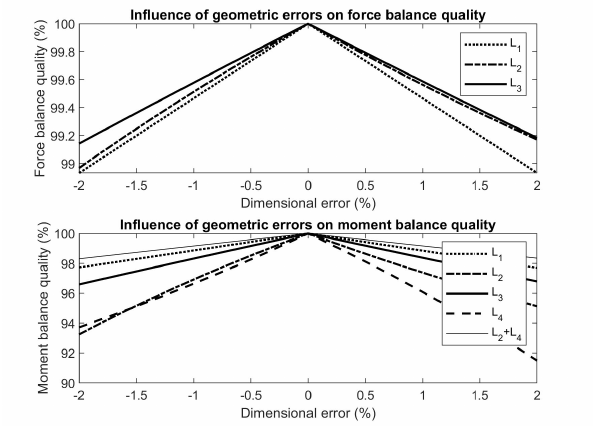
Figure 9. The influence of the geometric deviations on the balance quality shows that geometric error have a significantly larger impact on the moment balance quality than on the force balance